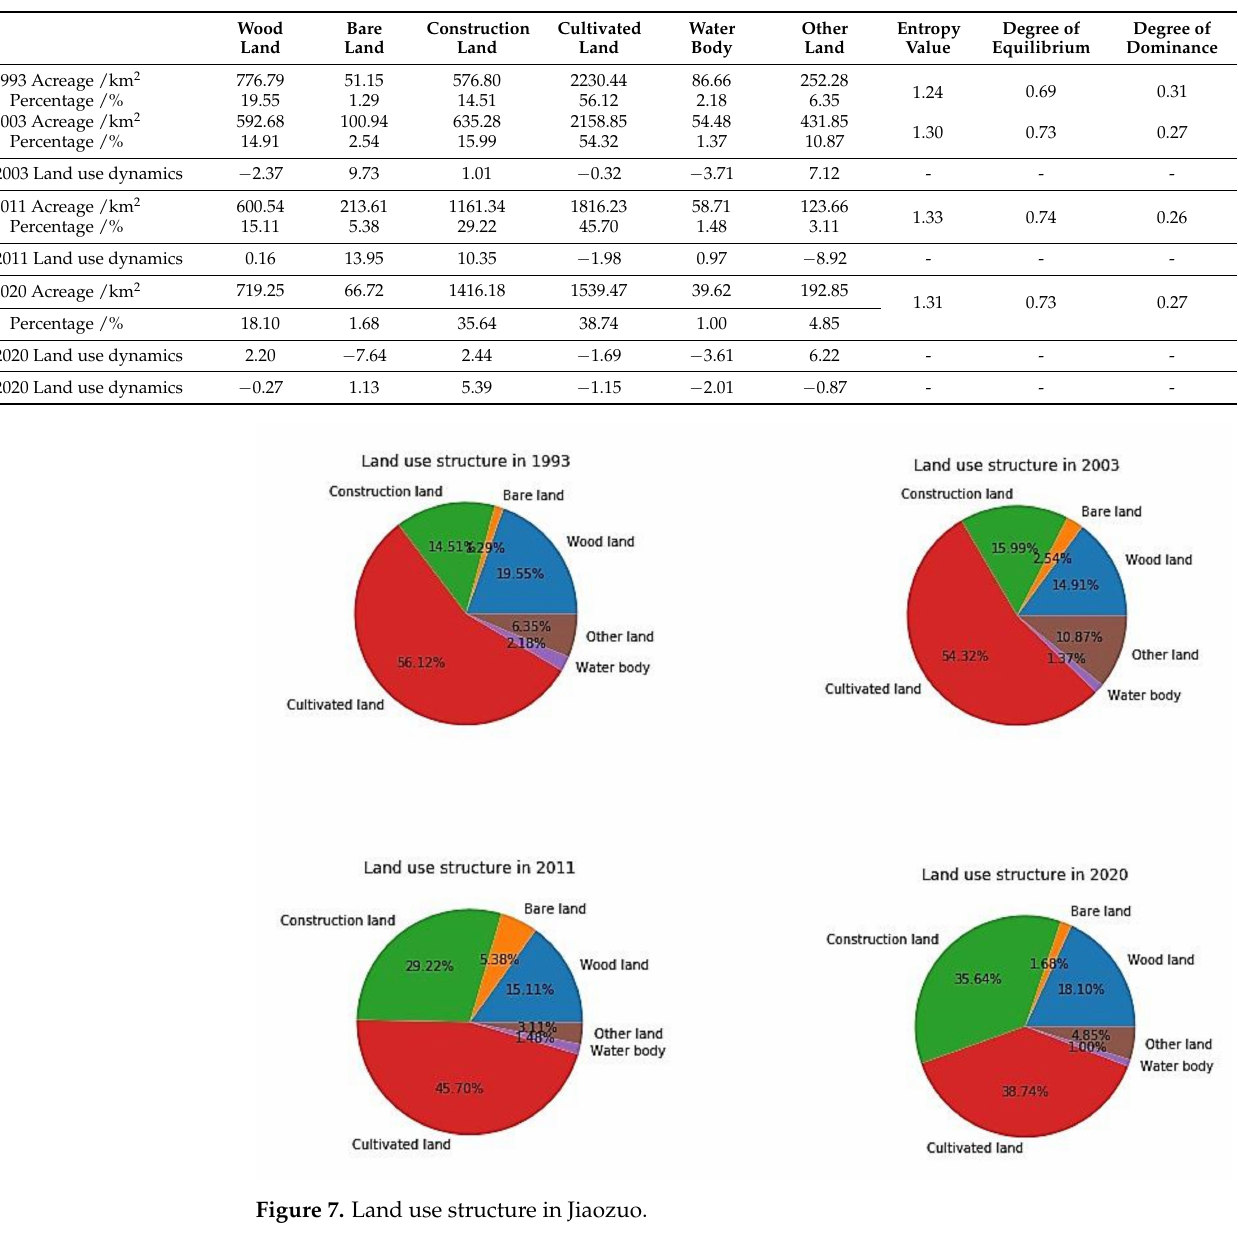
Table 4. Statistical table of land type change data from 1993 to 2020.